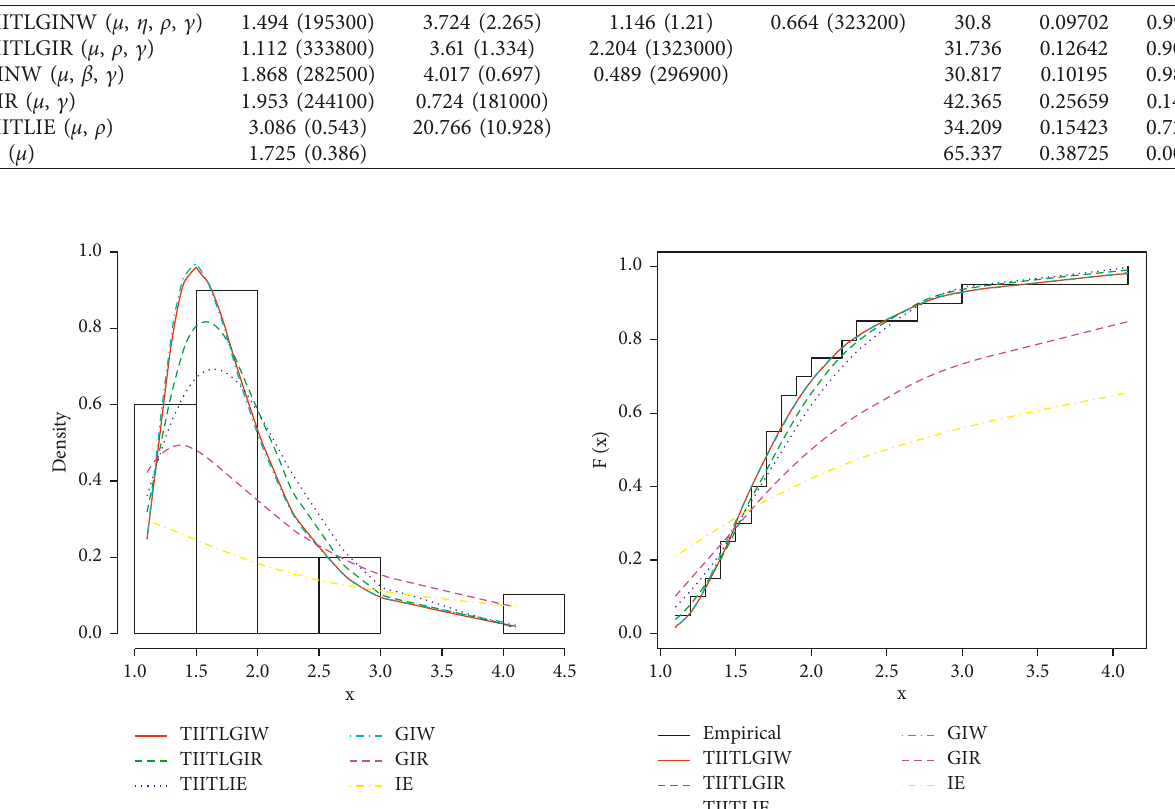
Figure 3: The empirical pdf and empirical cdf of the TIITLGINW